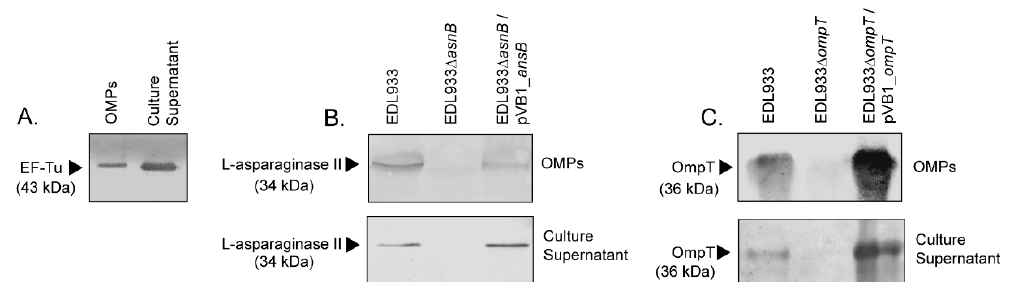
Figure 1. Determination of the presence of EF-Tu, L -asparaginase II and OmpT in outer membrane protein (OMP) extracts and culture supernatants. Protein extracts were separated by SDS-PAGE (12% acrylamide) and analyzed by Western blot assay. Arrows indicate the detection of the corresponding protein. ( A ) Identification of EF-Tu in OMPs and culture supernatant of the EDL933 strain. Monoclonal anti-EF-Tu antibody (mAb 900) was used in a dilution of 1:2000, followed by anti-mouse IgG, HRP conjugate diluted 1:5000. ( B ) Identification of L -asparaginase II in the OMP extracts and culture supernatant obtained from the EDL933, the isogenic mutant ELD933 ∆ ansB and the complemented ELD933 ∆ ansB /pVB1_ ansB strains. Anti- L -asparaginase II antibody was used in a dilution of 1:2000, followed by anti-rabbit IgG, HRP conjugate diluted 1:5000. ( C ) Identification of OmpT in the OMP extracts and culture supernatant obtained from the EDL933, the isogenic mutant ELD933 ∆ ompT and the complemented ELD933 ∆ ompT /pVB1_ ompT strains. Anti-OmpT antibody was used in a dilution of 1:3000, followed by anti-rabbit IgG, HRP conjugate diluted 1:5000.